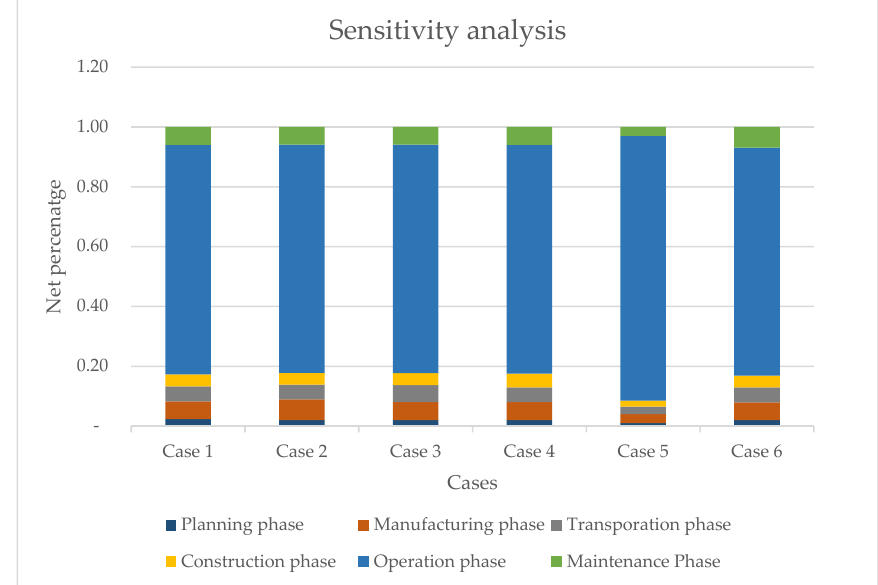
Figure 8. Sensitivity analysis of LCC of energy for HBs.